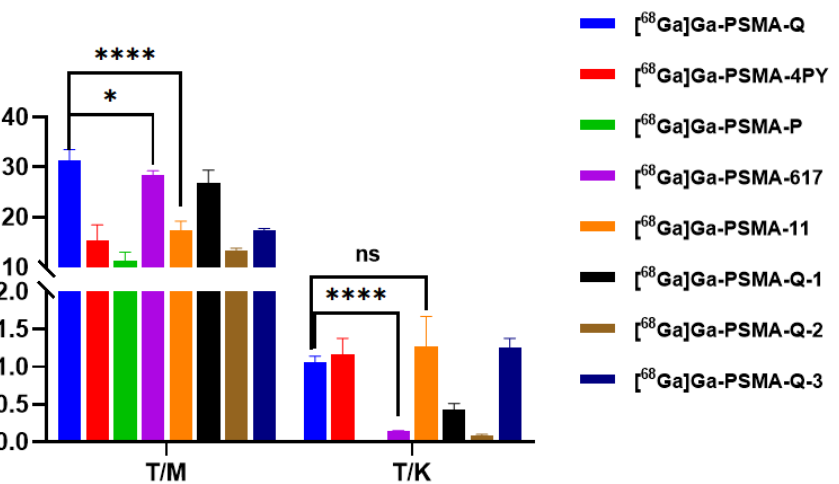
Figure 6. Tumor-to-muscle ratio (T/M) and tumor-to-kidney ratio (T/K) values of novel radiotracers and [ 68 Ga]Ga-PSMA-617 (0.74 MBq/mouse) in 22Rv1 tumor-bearing mice at 60 min p.i. ( n = 4/time point) (* p < 0.05, **** p < 0.0001). In normal organs, the highest uptake of each tracer was observed in the kidneys.